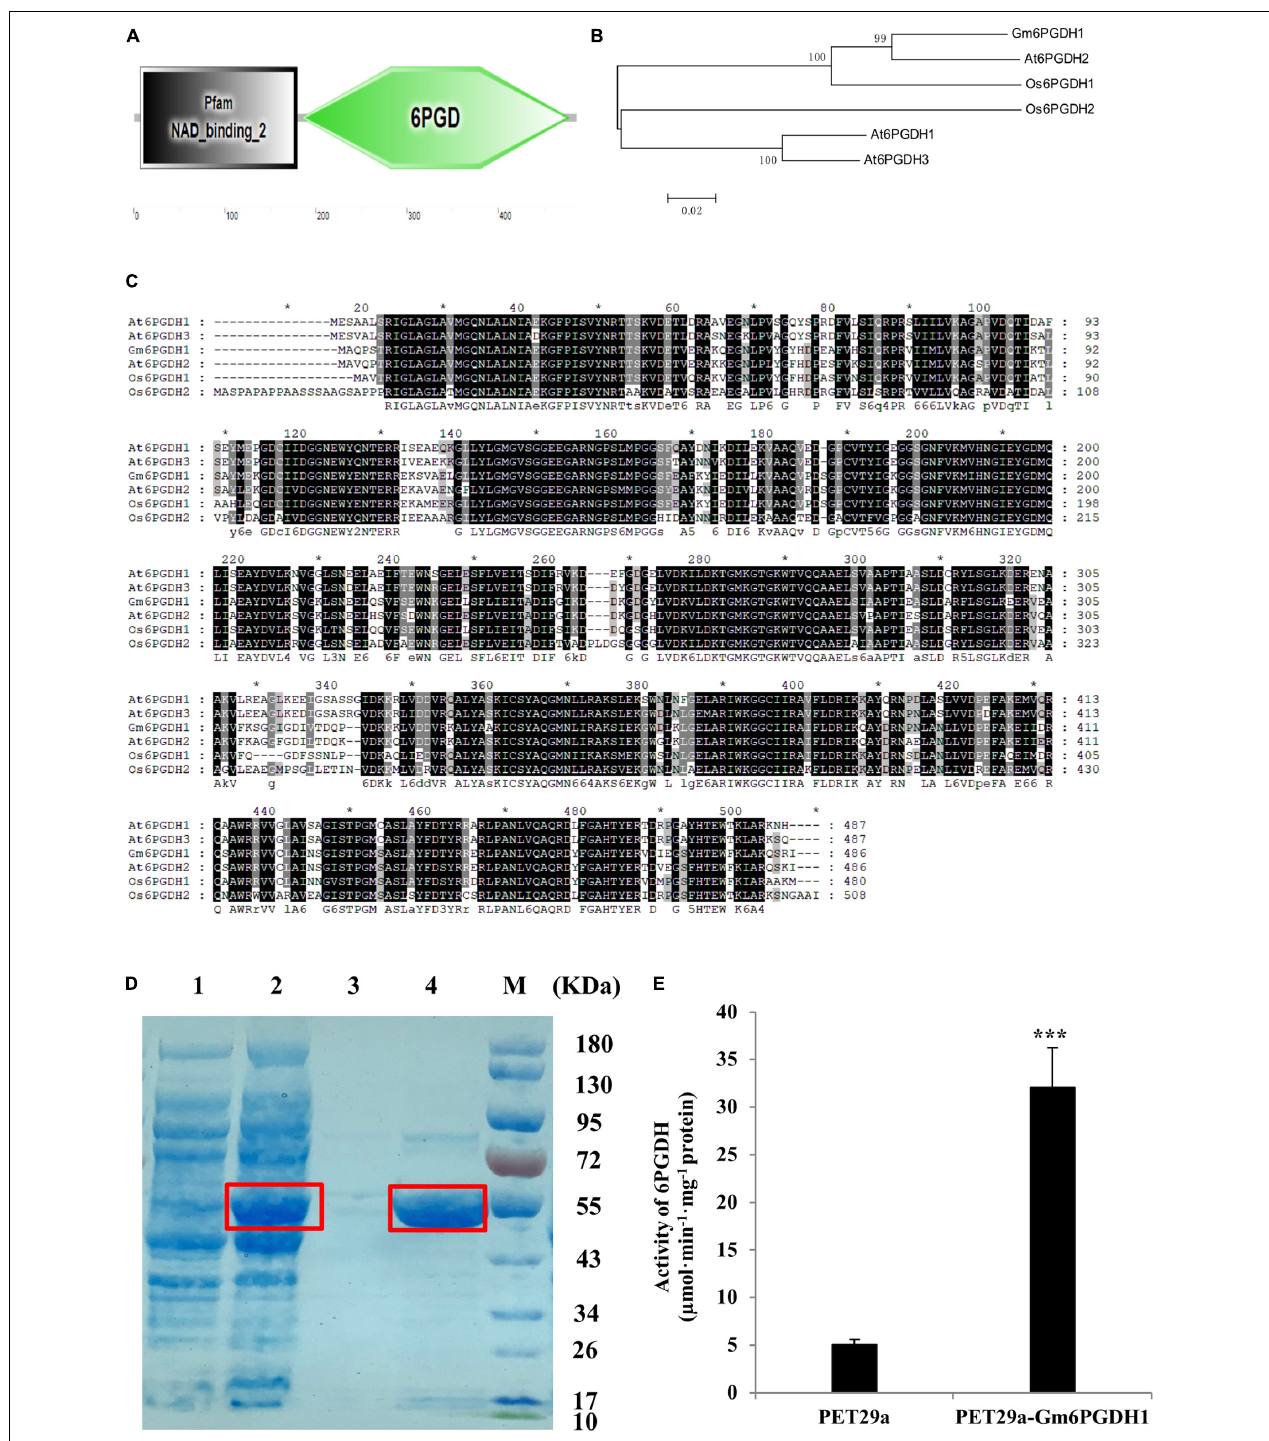
FIGURE 1 | Protein structures, prokaryotic induction, and enzyme activity determination of Gm6PGDH1 . (A) Domain analysis of Gm6PGDH1. (B) Phylogenetic tree constructed based on Gm6PGDH1 and the other plant 6PGDH proteins. (C) Protein sequence comparison between Gm6PGDH1 and Arabidopsis (At6PGDH1, At6PGDH2, and At6PGDH3) and rice (Os6PGDH1 and Os6PGDH2) 6PGDH proteins. Identical amino acids are shown with a black background, and analogous amino acids are shaded in gray. (D) Coomassie-stained 10% SDS-PAGE of cell extract. Lane 1: Rosetta (DE3) Escherichia coli strain expressing empty vector protein (PET29a); Lane 2: DE3 expressing His-tagged Gm6PGDH1 fusion protein (PET29a-Gm6PGDH1); Lane 3: Purified PET29aprotein; Lane 4: Purified PET29a-Gm6PGDH1 fusion protein; M: protein maker. The target protein was in the red frame. (E) GPDH enzyme activities from Gm6PGDH1 fusion protein. Data means ± SD ( n = 3). Asterisks indicate a significant difference from the PET29a (Student’s t -test, *** P < 0.001).